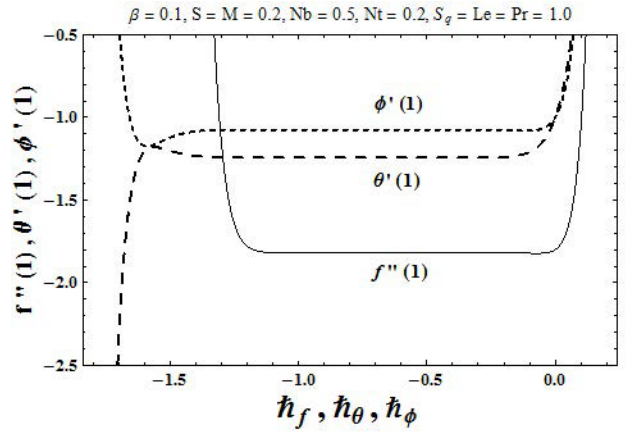
Figure 2. ¯ h -Curves for f , θ and φ at the upper